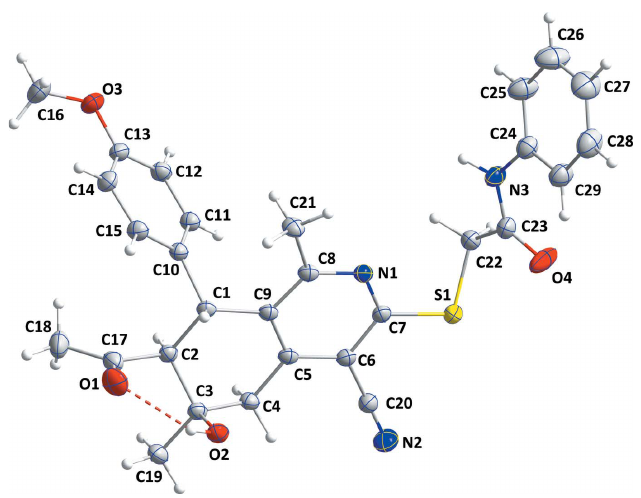
Figure 1 The title molecule with the atom-labelling scheme and 50% probability ellipsoids. The intramolecular hydrogen bond is depicted by a dashed